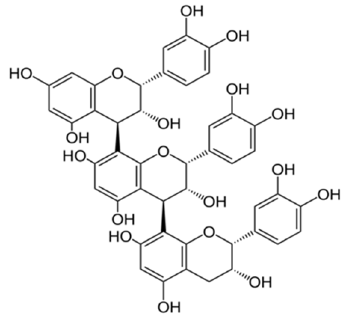
Figure 1. The chemical structure of procyanidin C1 (PC-1).